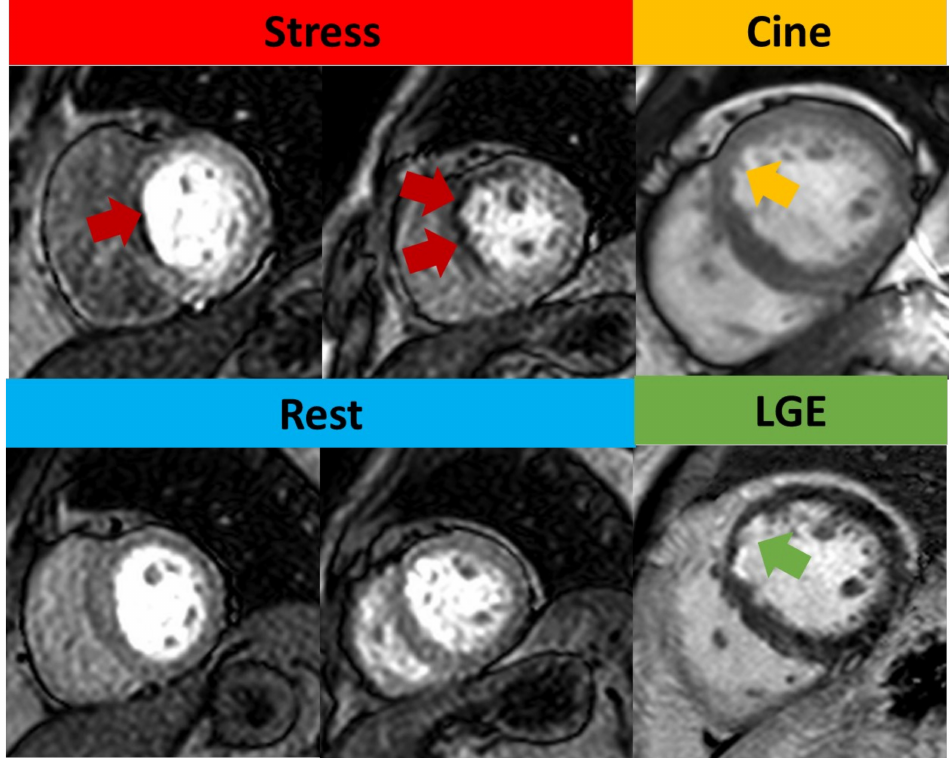
Figure 4. Qualitative assessment of stress CMR. Subendocardial perfusion defects presented on the basal septum and mid-anteroseptal wall (red arrow) but with normal rest perfusion. Cine image shows thinner myocardium (yellow arrow) compared to remote myocardium. LGE shows subendocardial enhancement (green arrow), consistent with left anterior descending artery (LAD) infarction. As this infarct involves <50% of the wall thickness, this was regarded as